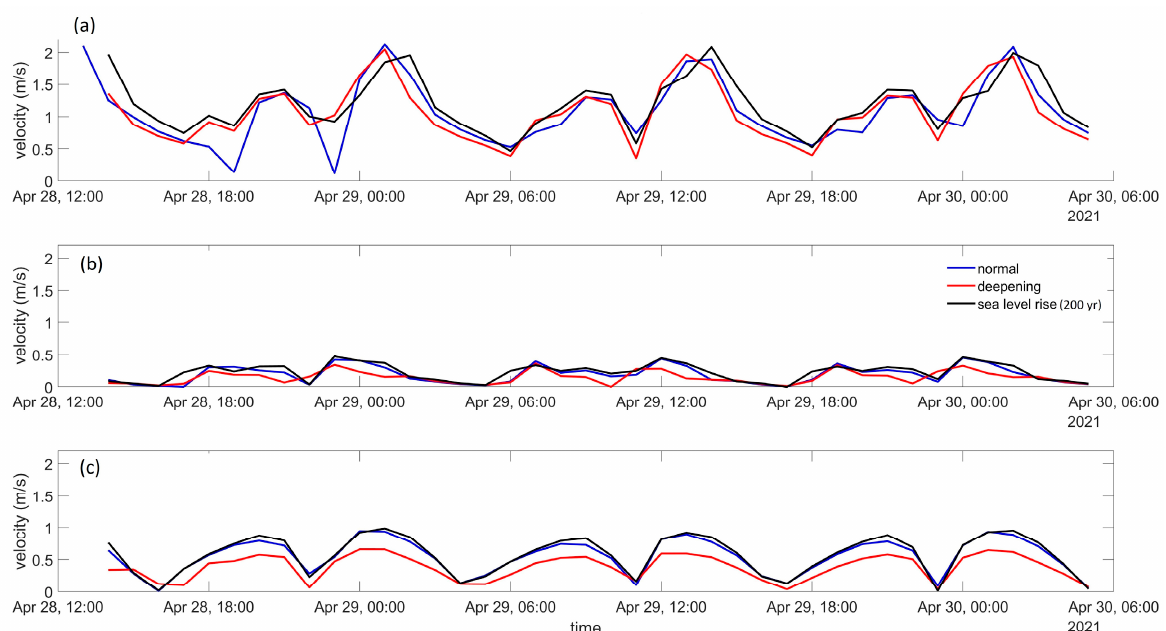
Figure 6. Modeled velocity currents at surface layer for the highest Sizygy of 2021 in Buenaventura Bay of the monitoring points ( a ) A, ( b ) B and ( c )